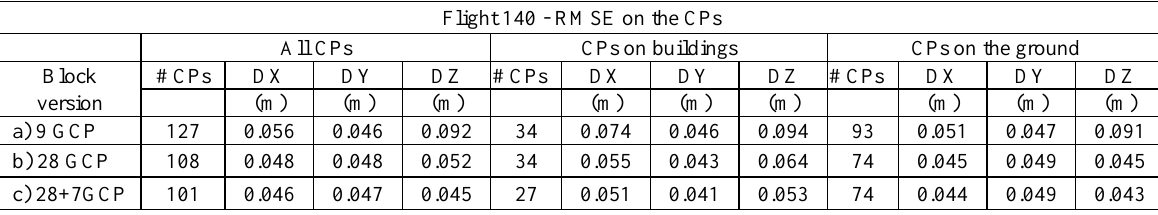
Table 5 – Flight 140: coordinates difference value in the 3 configuration of UAS block on all CPs, on buildings and on the ground.